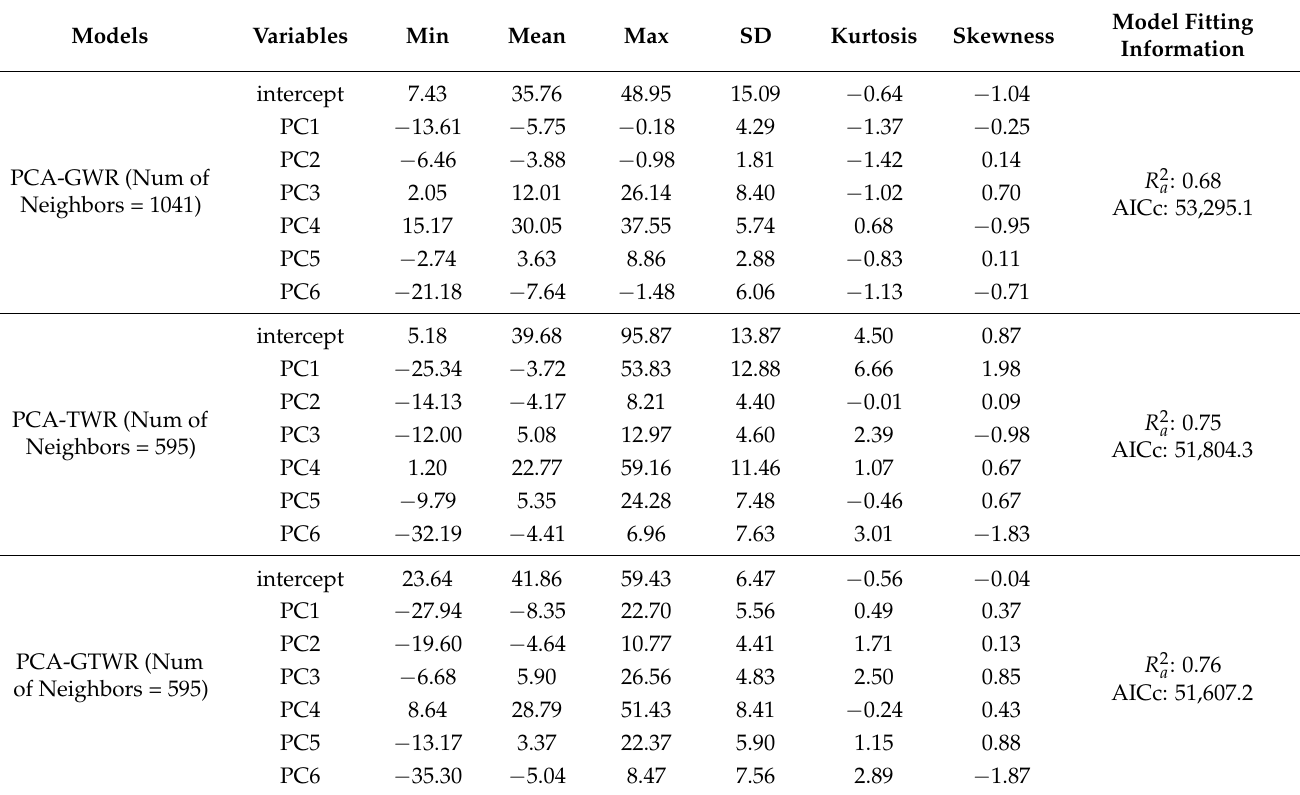
Table 4. PCA-GWR, PCA-TWR, and PCA-GTWR parameter estimates of PM 2.5 (the models are fitted by an adaptive neighbor selection